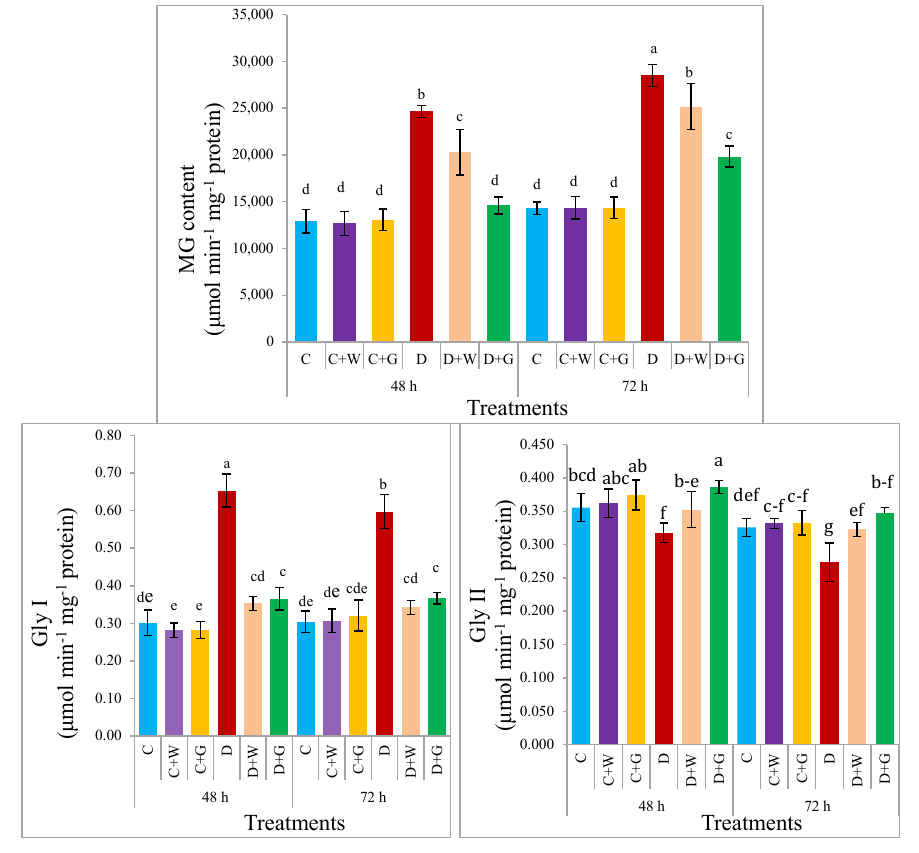
Fig. 6 Effect of drought stress and exogenous GA on MG content and glyoxalase system activity in wheat. Codes are as for Fig.